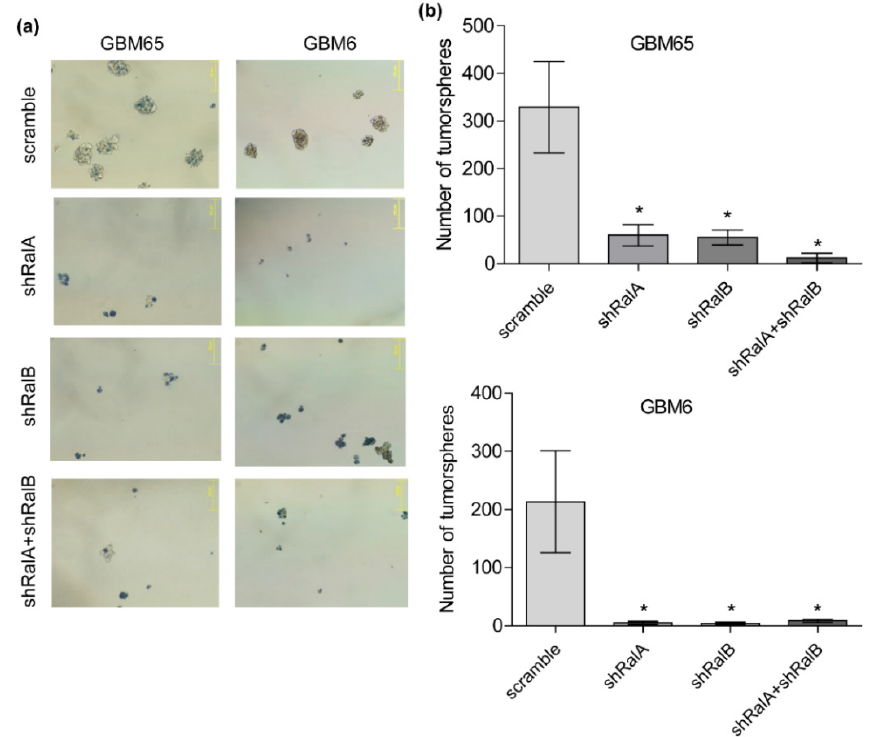
Figure 6. Ral GTPases downregulation inhibits the growth of GBM cells as tumorspheres. GBM65 and GBM6 were infected with lentivirus, mediating interference RNA against RalA and RalB or both, and cells were seeded under special conditions in order to form tumorspheres. After 48 h, tumorspheres were precipitated and stained with trypan blue. ( a ) Representative images of tumorspheres (150 μm bar). ( b ) Diagrams representing the number of spheres observed in ( a ). Spheres were counted using the ImageJ program. Values represent mean ± SEM ( n = 3). Significance was calculated by ANOVA and Tukey-HSD post-test. Significance of scramble versus shRalA, shRalB, and shRalA + shRalB groups is represented (* p ≤ 0.05).